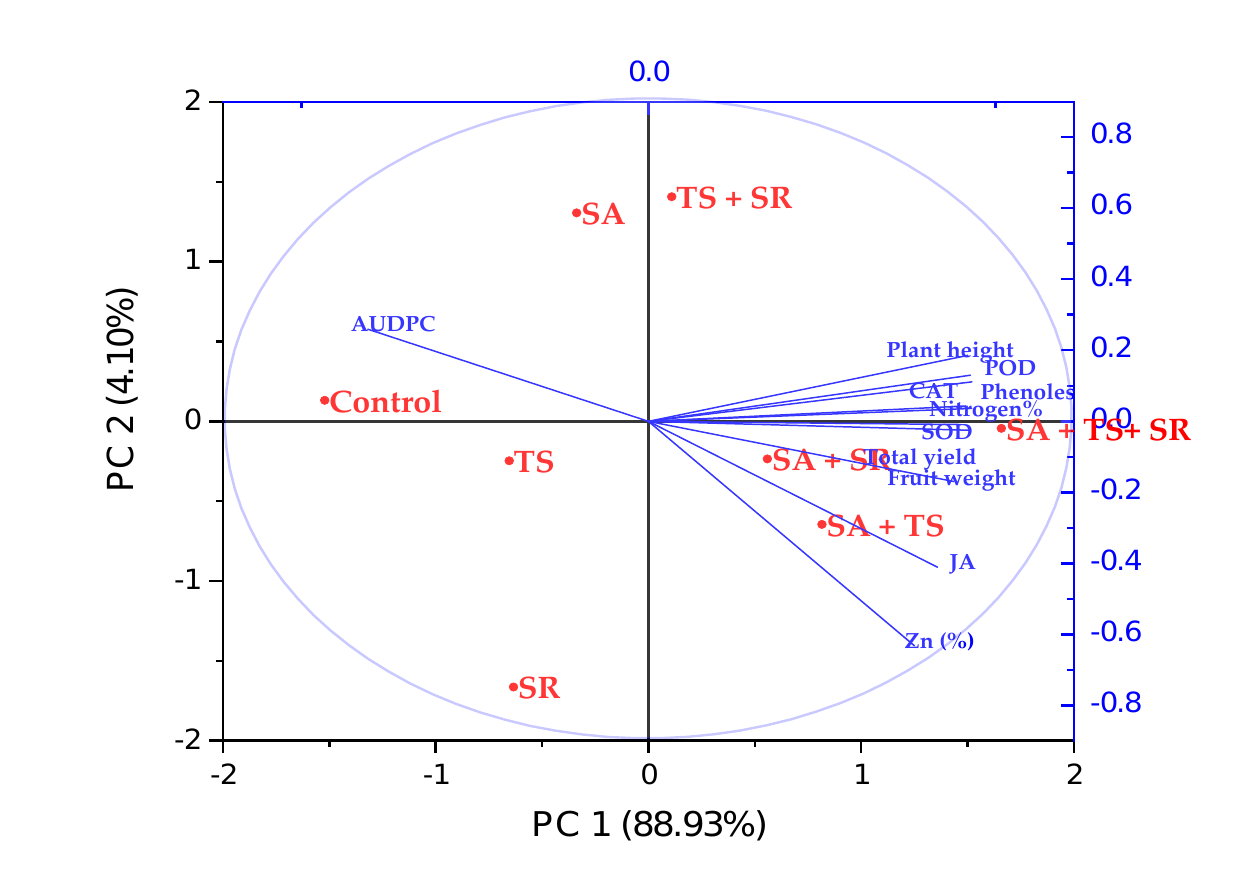
Figure 8. Biplot of the first two principal components for the morphological, yield, AUDPC, and physiochemical traits of sqaush plants. Red circles indicate the eight treatments: shikimic acid (SA) seed priming rates 40 ppm and foliar applications of S. rochei (SR), T. asperellum (TS), S. rochei + T. asperellum (SR + TS), and water (control).